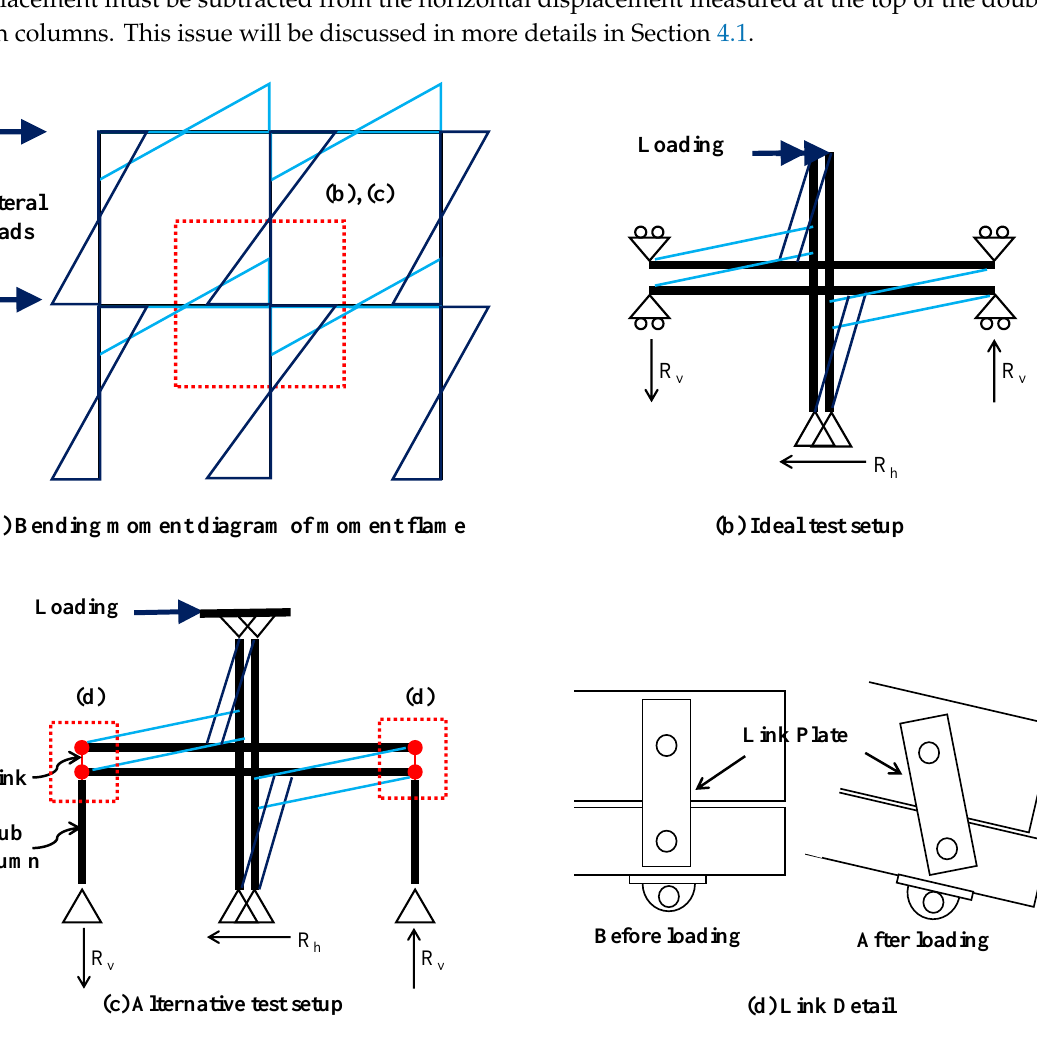
Figure 5. Determination of the test setup.